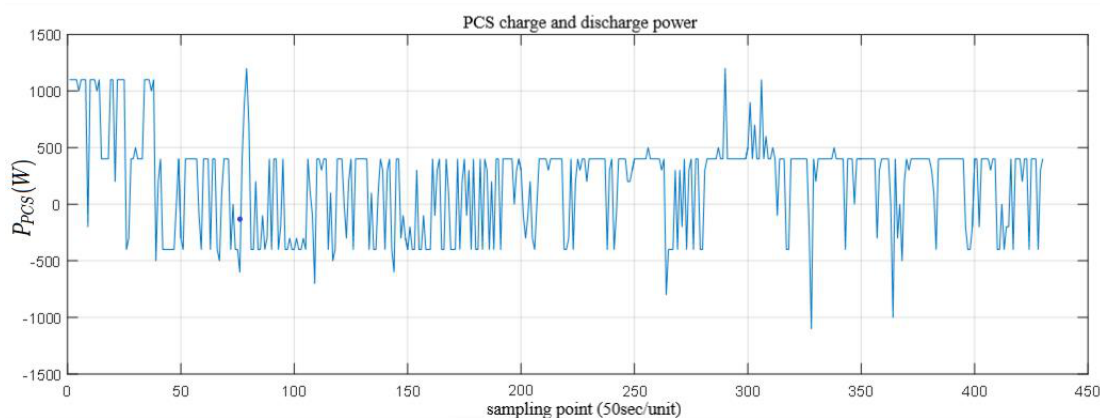
Figure 9. Schematic diagram of power conversion systems (PCS) charge and discharge power